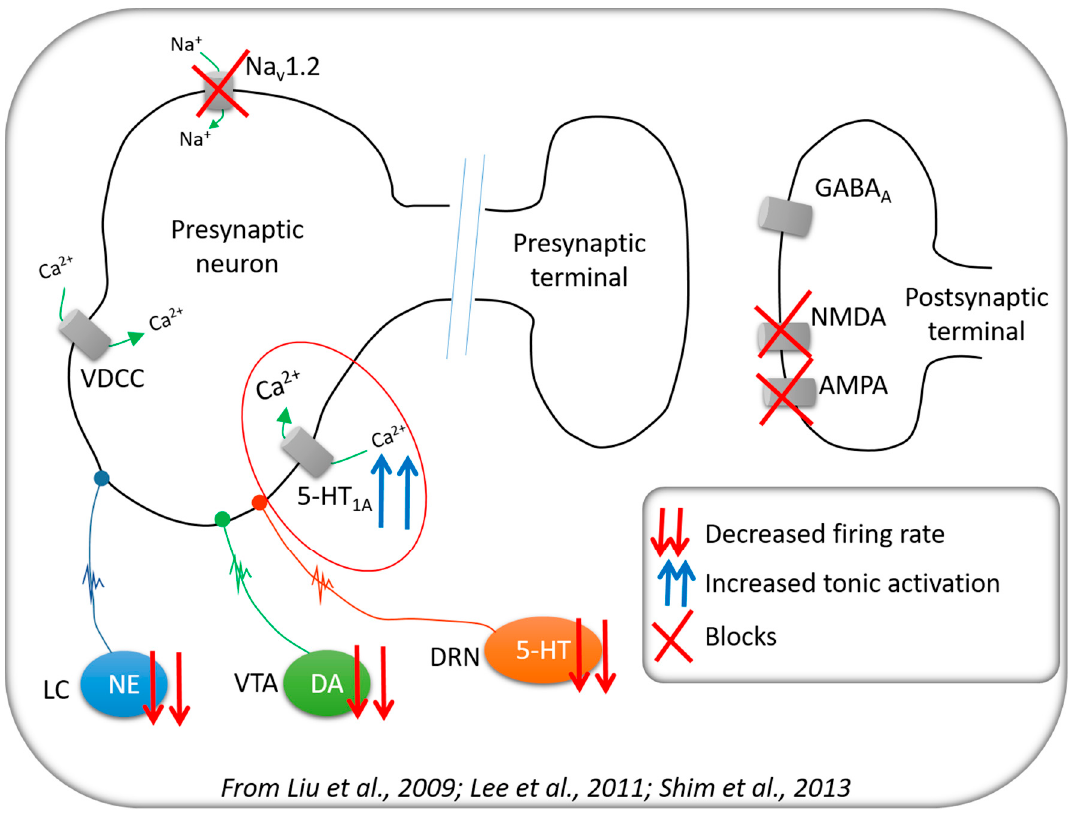
Figure 1. Summary of the main systems modulated by carisbamate. Legend: NE—norepinephrine; DA—dopamine; 5-HT—serotonin; VDCC—voltage-dependent calcium channel; LC—locus coeruleus; VTA—ventral tegmental area; DRN—dorsal raphe nucleus.